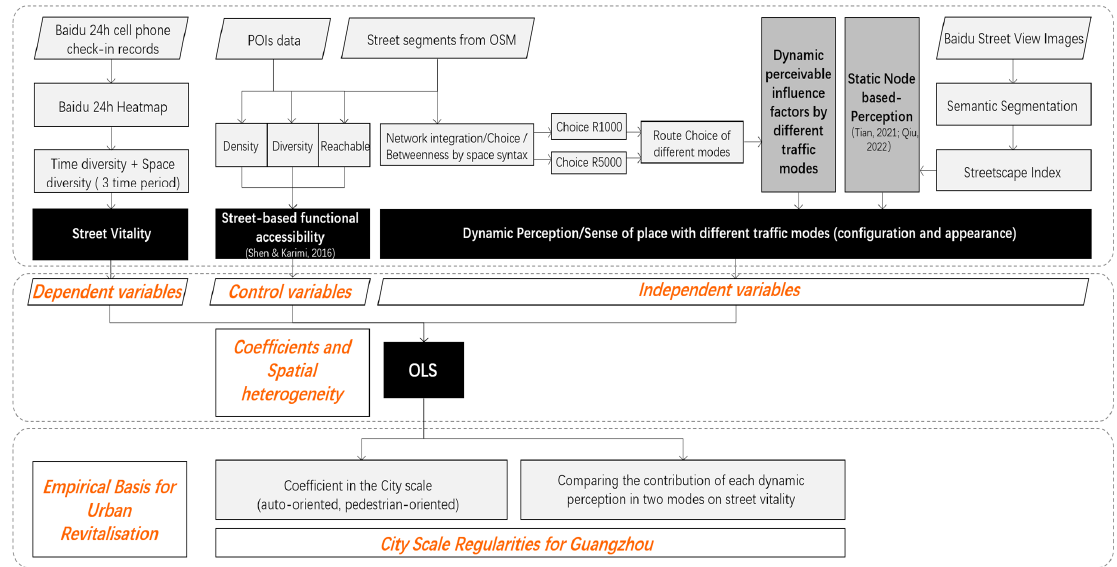
Figure 3. The analytical framework [6,68,69].